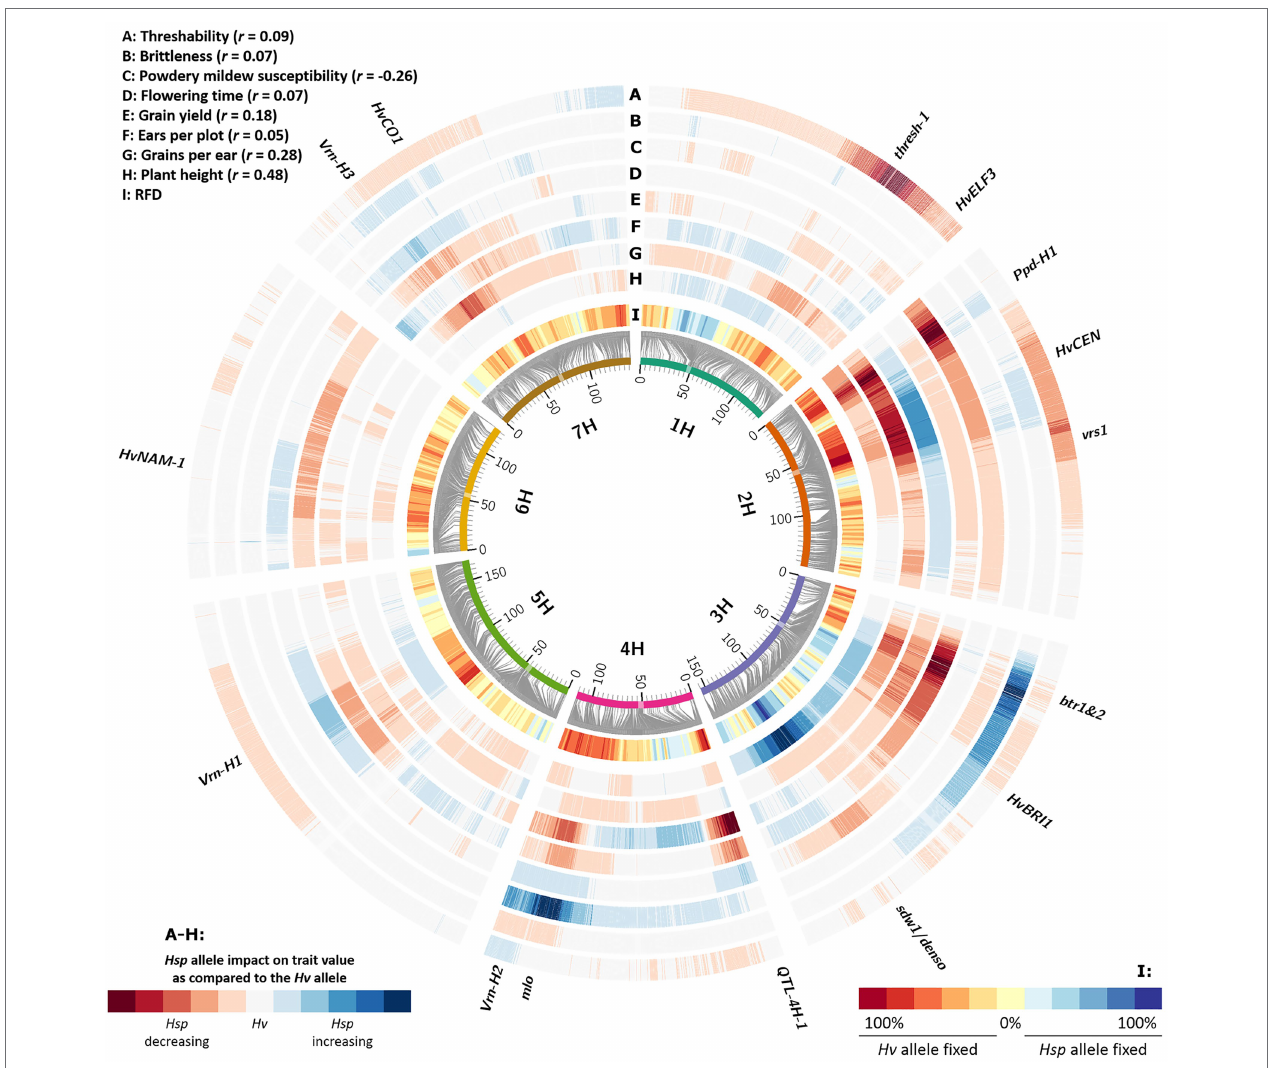
FIGURE 3 | Relative fixation direction (RFD) compared to Hsp allele effects of different agronomic traits. Barley chromosomes are indicated as inner circle of colored bars; centromeres are highlighted as transparent boxes. Grey connector lines represent the genetic position (in cM) of SNPs on chromosomes based on Maurer et al. (2015). The inner heat map (I) represents the RFD, indicating the tendency which allele was fixed in originally heterozygous HEB-25 lines, summarized over 10 consecutive SNPs. The other heat maps (A-H) indicate Hsp allele effect size and direction as compared to the Hv allele, based on linear regression. The extreme values of the heat maps were standardized to the most extreme observed absolute Hsp allele effect for each trait. Candidate genes of barley domestication and flowering time as well as further striking genomic regions are indicated